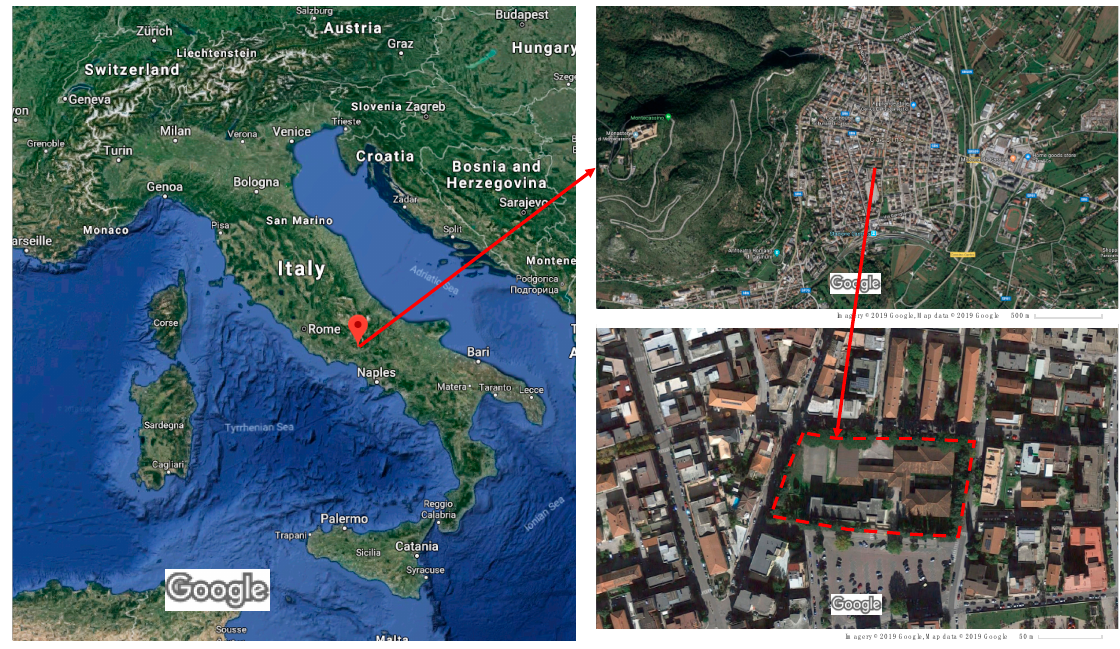
Figure 1. Maps of Cassino and identification of the school.